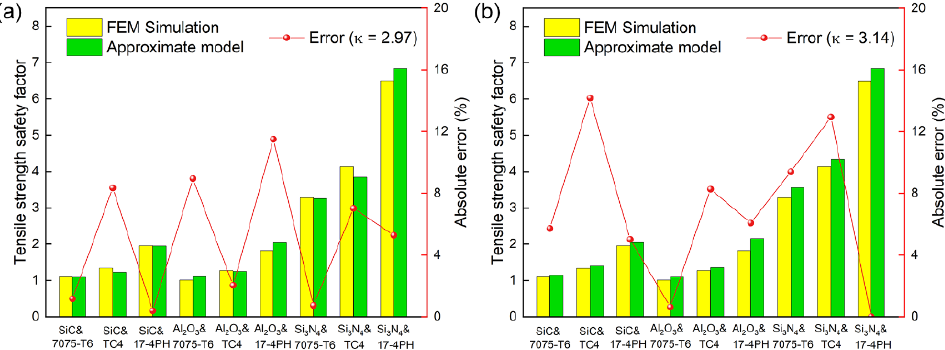
Figure 7. Tensile strength safety factor and its absolute error for nine groups of ceramic pressure housings. ( a ) κ = 2.97; ( b ) κ = 3.14. housings. ( a ) κ = 2.97; ( b ) κ =